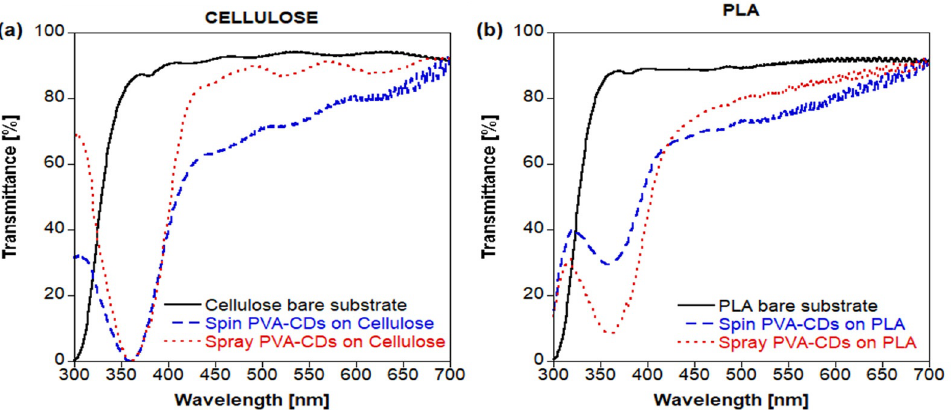
Figure 4. Transmittance spectra of ( a ) cellulose and ( b ) PLA bare substrates (black line), spin-coated films (dashed blue line), and spray-coated films (dotted red line).